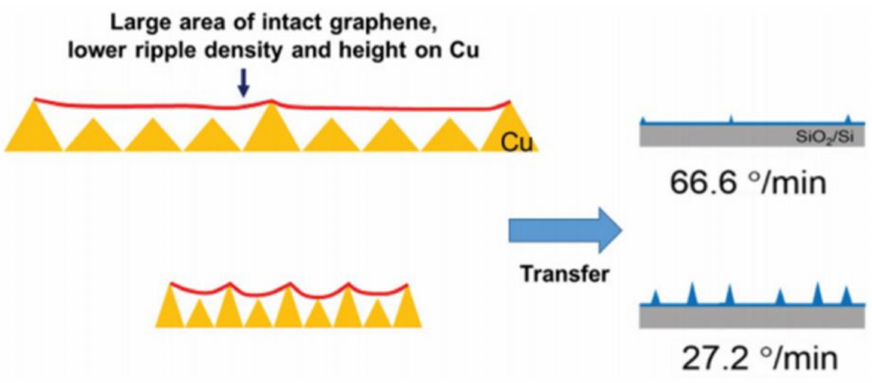
Figure 17. Overall schematic picture was shown by comparing two extreme cooling rates. Reprinted with permission from ref.